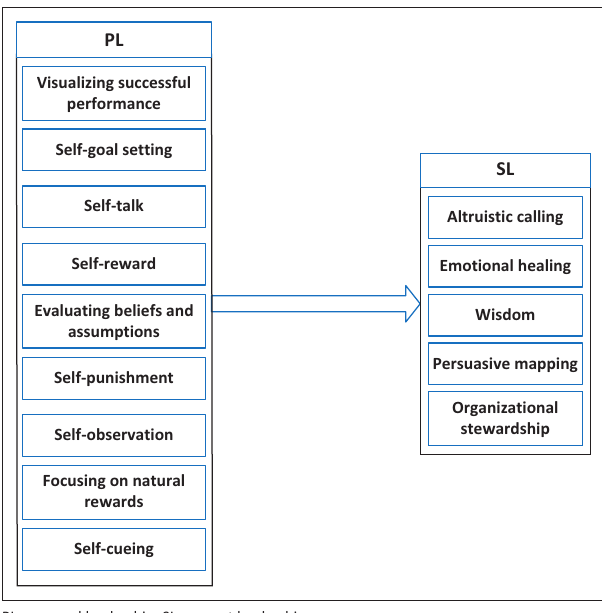
FIGURE 1: Conceptual model of personal leadership as an antecedent of servant leadership and its associated dimensions.